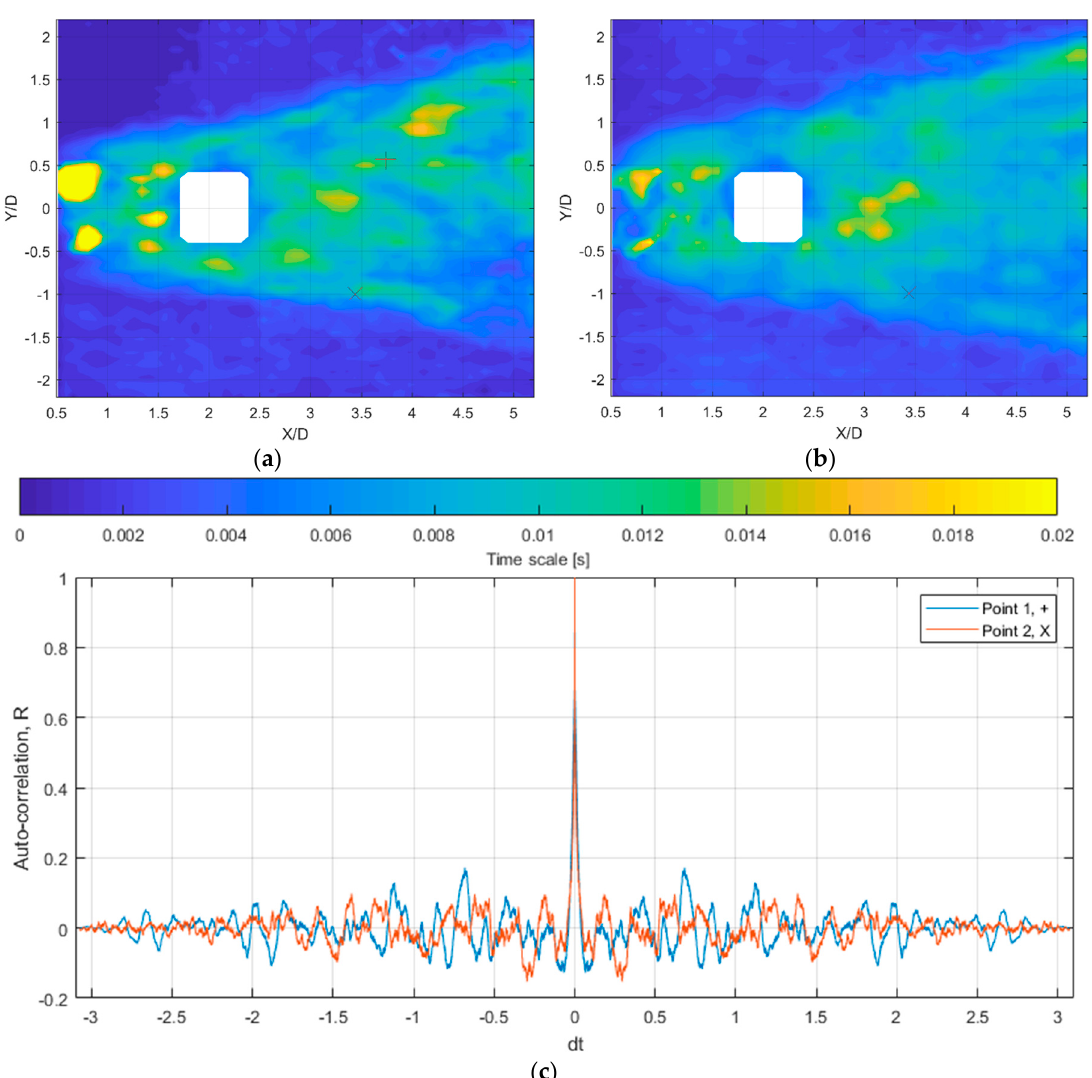
Figure 20. Integral time scale distributions associated with turbulent parts. ( a ) uu; ( b ) vv; ( c ) Auto-correlation function, uu about two example points, locations indicated in ( a ) and ( b ).